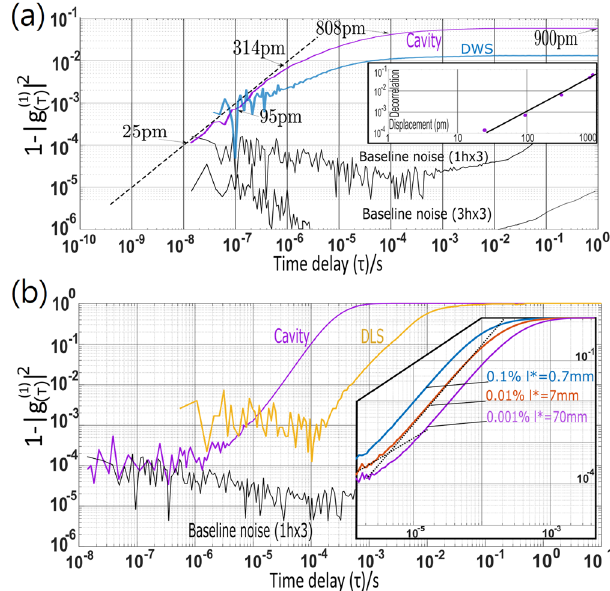
Fig. 4 Interferometric response to intracavity light scattering perturbations. Data averaged from N = 3 repetitions of 1 h acquisition times, laser power is 300 mW for all experiments. The cavity has a volume V c = 118 cm 3 , a wall area Σ c = 134 cm 2 , and a mean chord length (cid:1) Λ : 53cm. The effective gain is g ≈ 1700. a Plot (purple line) of the e c ¼ 3 speckle intensity decorrelation 1 (cid:2) j g ð 1 Þ ð τ Þj 2 measured inside the cavity and caused by the thermal fl uctuations of a jammed monodisperse emulsion of polydimethylsiloxane (PDMS) oil-in-water, with an average droplet radius 459 ± 15 nm, volume fraction 0.738, transport mean free path l (cid:5) ¼ 0 : 25mm. The sample volume is V s 1 = 0.785 cm 3 , the surface area s 1 Σ = 4.71 cm 2 , and the mean chord length (cid:1) Λ : 67cm. The arrows point s 1 s 1 ¼ 0 to speci fi c values of the root-mean-square (rms) displacement of the droplets computed from ref. 25 . Black curves represent the standard error ffiffiffiffi p σ ð τ Þ = N measured with the empty unperturbed cavity from three 1 h ffiffiffiffi p j g ð 1 Þ j 2 acquisitions (rescaled by N compared to Fig. 2b). (Inset) Measured decorrelation amplitude as a function of the rms displacement amplitude in picometers, with the solid line showing the linear response. The (blue line) represents a measurement of the same sample performed under the same experimental conditions on a self-made Diffusing Wave Spectroscopy setup. b Plots of the intensity decorrelation signal 1 (cid:2) j g ð 1 Þ ð τ Þj 2 for water suspensions of 20 µ m diameter polymethyl methacrylate (PMMA) spheres in water. The response for a 10 − 5 volume fraction (purple line) inside the cavity is compared to the baseline noise amplitude (black line) of an empty unperturbed cavity. The (yellow line) represents a measurement of the same sample performed under the same experimental conditions using a commercial dynamic light spectroscopy instrument. (Inset) Decorrelation signal obtained with the cavity for three volume fractions, 10 − 3 (blue, l * = 0.7 mm), 10 − 4 (red, l * = 7 mm) and 10 − 5 (purple, l * = 70 mm). All samples have a volume V s 2 = 19.6 cm 3 , a surface area Σ s 2 = 55 cm 2 , and a mean chord length (cid:1) Λ s 2 ¼ 1 :